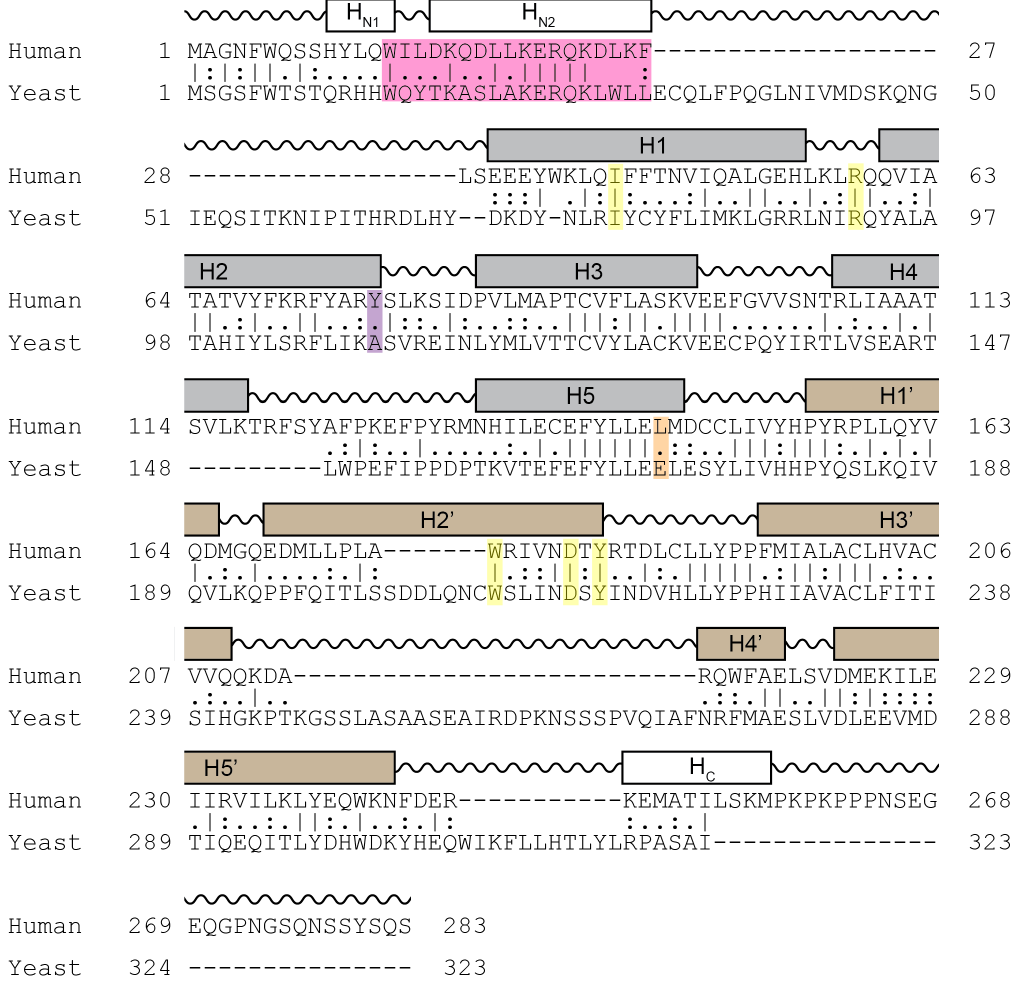
Figure 3. Sequence homology comparison between human and yeast cyclin C. Shown is the alignment of the primary sequences of human and yeast cyclin C. Grey and brown boxes denote α -helical segments of the N- and C-terminal cyclin box domains, respectively. Shown is the HAD domain (pink), the two amino acid residues Tyr76 (Ala110 in yeast) (magenta) and Leu145 (Glu170 in yeast) (orange) required for Cdk8 binding, and five highly conserved residues at the surface of a cyclin C-specific groove between the two cyclin box domains (human: Ile42, Arg58, Trp177, Asp182, and Tyr184) (yellow) (see Section 5.1.1) [47].